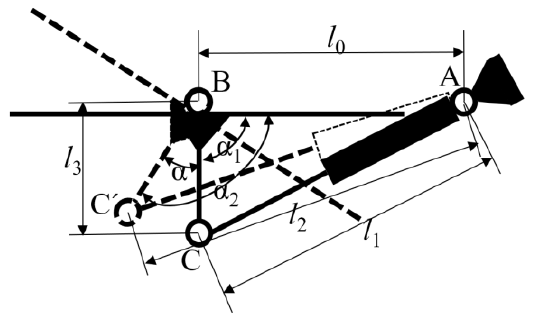
Figure 3. Simplified model of the screen-leveling mechanism.